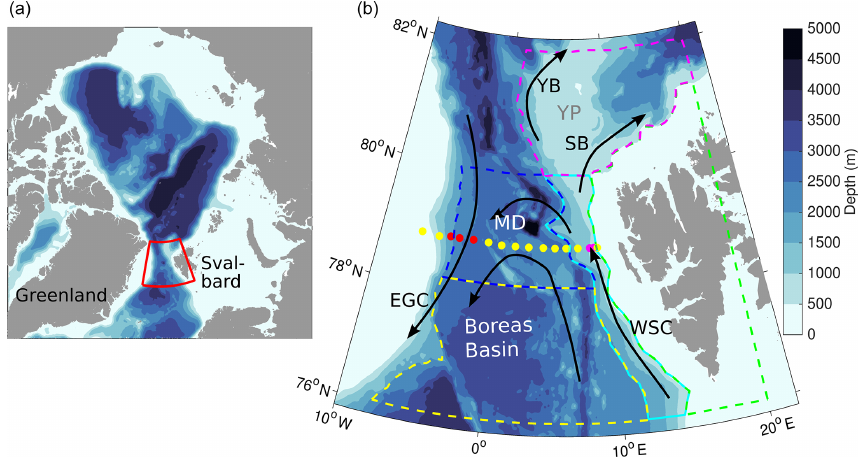
Figure 1. Bathymetry of the Arctic Ocean ( a , red box indicates our study region) and Fram Strait (b) . Coloured polygons in (b) indicate regions used for analysis: Svalbard shelf (green), West Spitsbergen Current (cyan), central southern Fram Strait (yellow), central northern Fram Strait (blue), and Yermak and Svalbard Branch (magenta). Coloured dots indicate moorings deployed across Fram Strait at 78 ◦ 50 (cid:48) N; red and magenta dots show moorings used to compute velocity time series representative for the EGC and WSC, respectively. Black arrows show major currents in Fram Strait (WSC: West Spitsbergen Current, EGC: East Greenland Current, YB: Yermak Branch, SB: Svalbard Branch). MD and YP indicate the locations of the Molloy Deep and the Yermak Plateau,